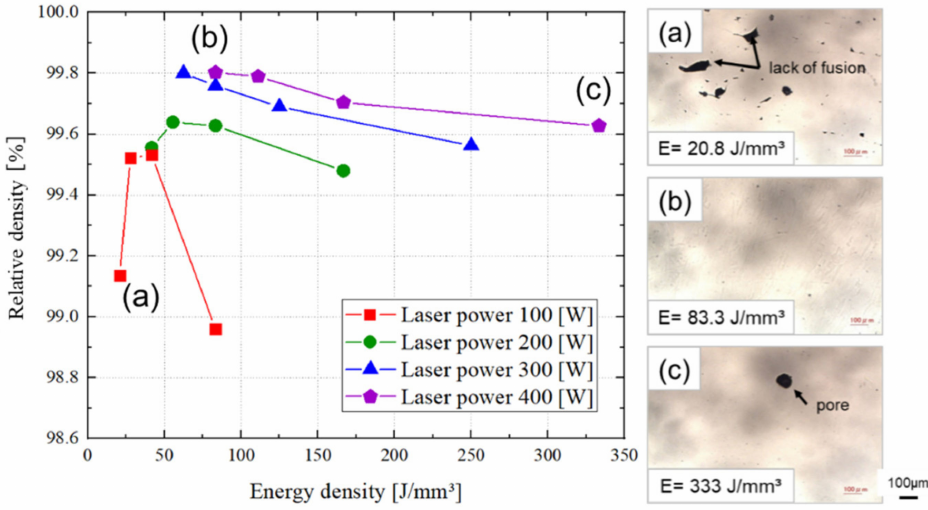
Figure 5. Variations of relative density of the as-built specimens as a function of energy density and the representative optical micrographs ( a – c ) of the as-built